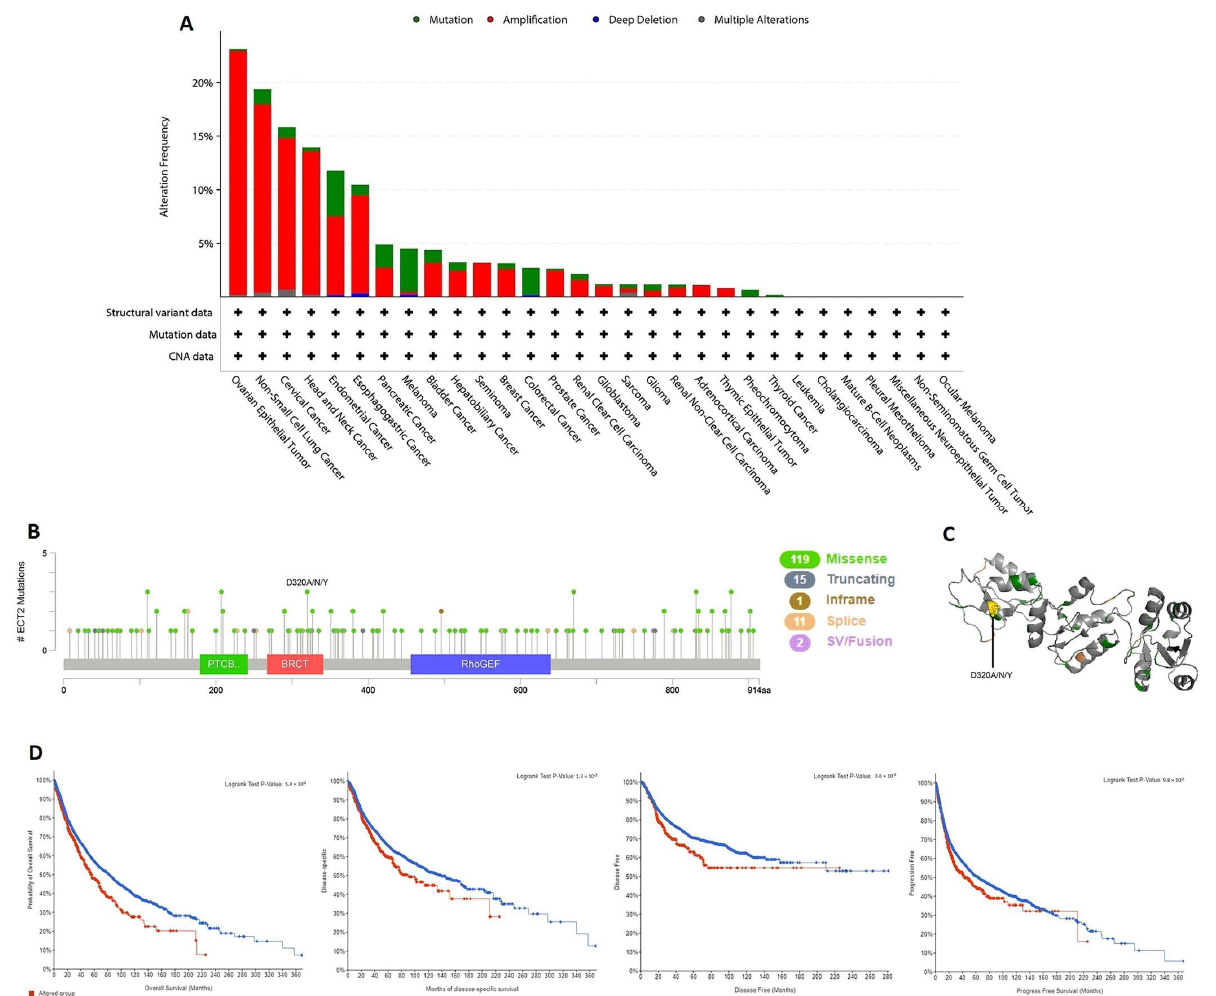
Figure 5. Mutation assessment for ECT2 using the cBioPortal tool. ( A ) The alteration frequency with mutation type in a panel of analyzed human cancers. ( B ) A map representation for sites and types of ECT2 mutations. ( C ) The 3D structure of ECT2, with a highlight on the most altered site. ( D ) Assessment of the correlation between ECT2 mutation and disease-free, disease-specific, progression-free, and overall survival.